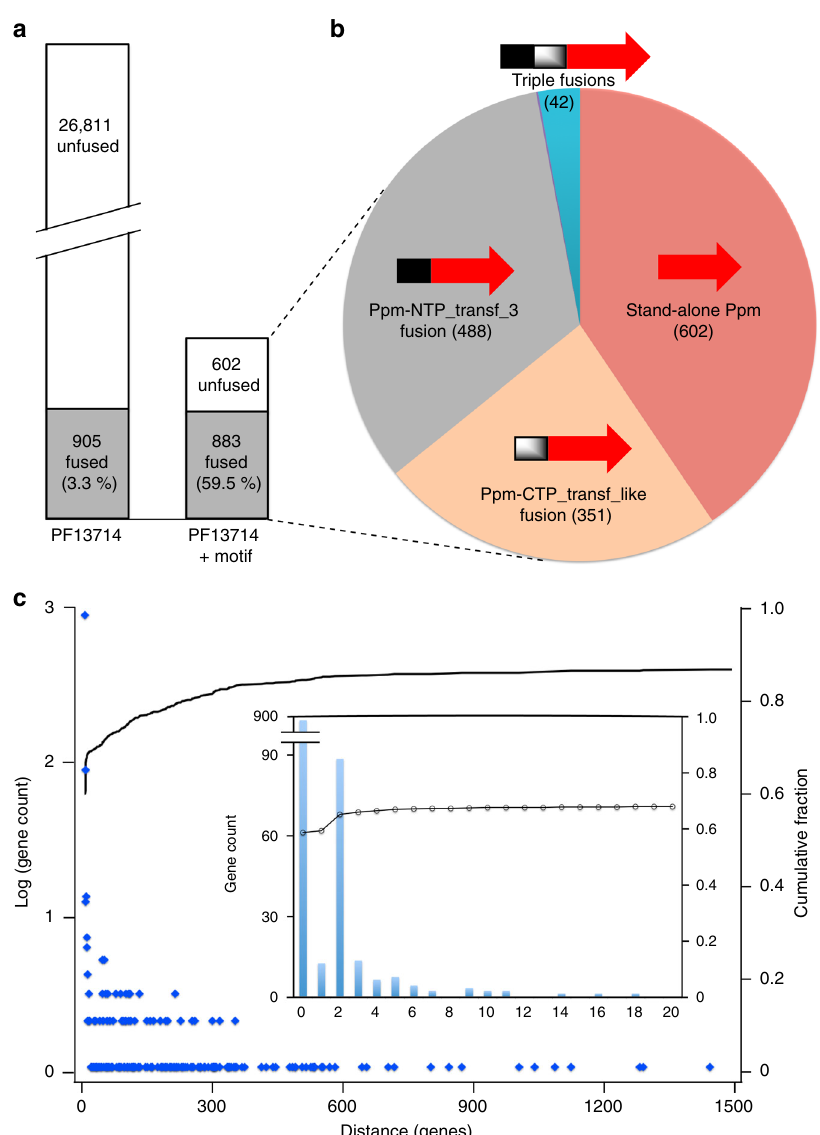
Fig. 2 Genomic relationships between ppm and nucleotidyltransferase-encoding genes. a Left: 27,716 non-redundant Ppm protein sequences were identi fi ed in NCBI ’ s refSeq prokaryotic genome database that matched the PF13714 HMM, of which 905 were fused to other domains. Right: After fi ltering for the presence of the characteristic Ppm motif (EDKXXXXXNS), 26,231 presumed non-Ppm sequences were removed. Only 22 of these removed sequences were fused to other domains. b Summary of the remaining 1485 predicted Ppm proteins and inventory of fusion status: Ppm alone (red, 40.5%); PF12804, MobA-like NTP transferase (NTP_transf_3; gray, 32.9%); PF01467, Cytidylyltransferase-like (CTP_transf_like; orange, 23.6%); not visible are two genes matching PF02775 and PF02776 (both TPP-binding domains), which corresponds to 0.1% of non-redundant Ppm proteins. The blue slice represents 42 triple fusion proteins (2.8% of all Ppm proteins) with Ppm fused to both PF12804 and PF01467. c Distribution of genomic distances (in genes) between ppm and the nearest of either PF12804 or PF01467. Blue dots represent logarithm of the number of genes counted for each distance (corresponding to left y-axis), and the line represents the cumulative fraction of genomic distances (right y -axis); 59.3% of nearest nucleotidyltransferase genes (those closest to ppm ) are fused to ppm (distance = 0), and only single counts occur at distances greater than ~350 genes. Inset : Number of genes for each distance up to 20, illustrating that two-thirds of nucleotidyltransferase genes are within ~5 genes of